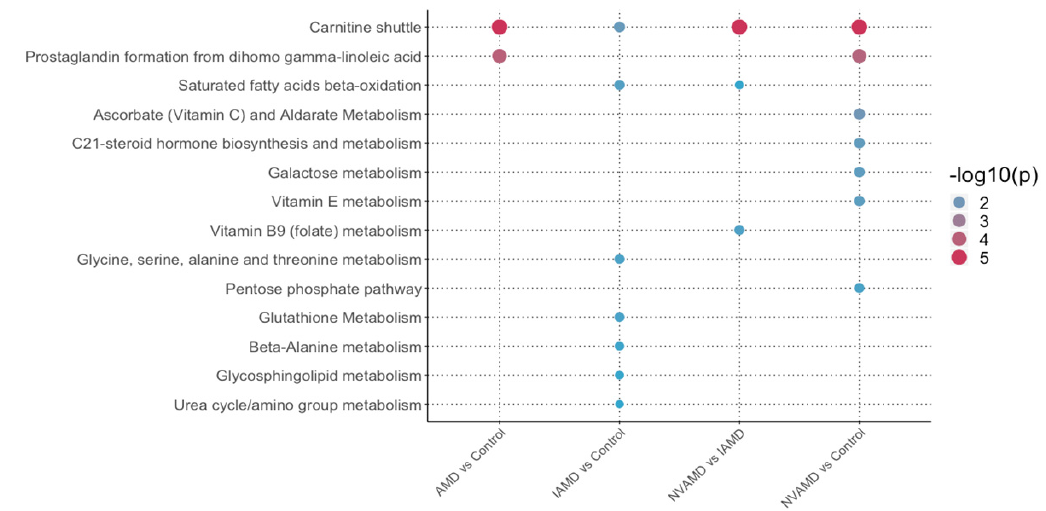
Figure 5. Pathways altered in AMD patients. Summary of the pathways altered in AMD patients compared to controls, as well as across stages of AMD. Pathway analysis was performed using Mummichog 2.0 on discriminatory metabolic features identified by PLS-DA at VIP ≥ 1.5. The NVAMD versus Control results are an updated reanalysis of data from Mitchell SL et al. 2018 and are included here for comparison. Size and color of circles indicate significance level. AMD: age-related macular degeneration; IAMD: intermediate AMD; NVAMD: neovascular